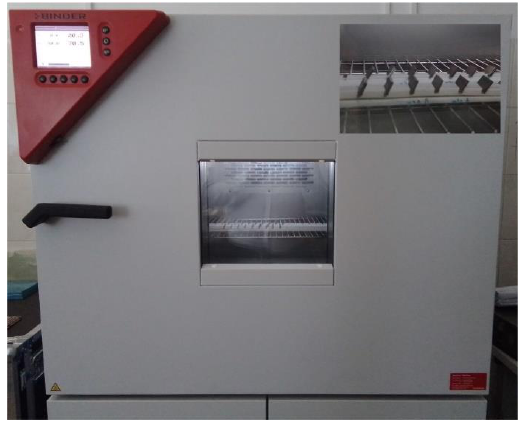
Figure 2. The environmental chamber used for hygrothermal conditioning.